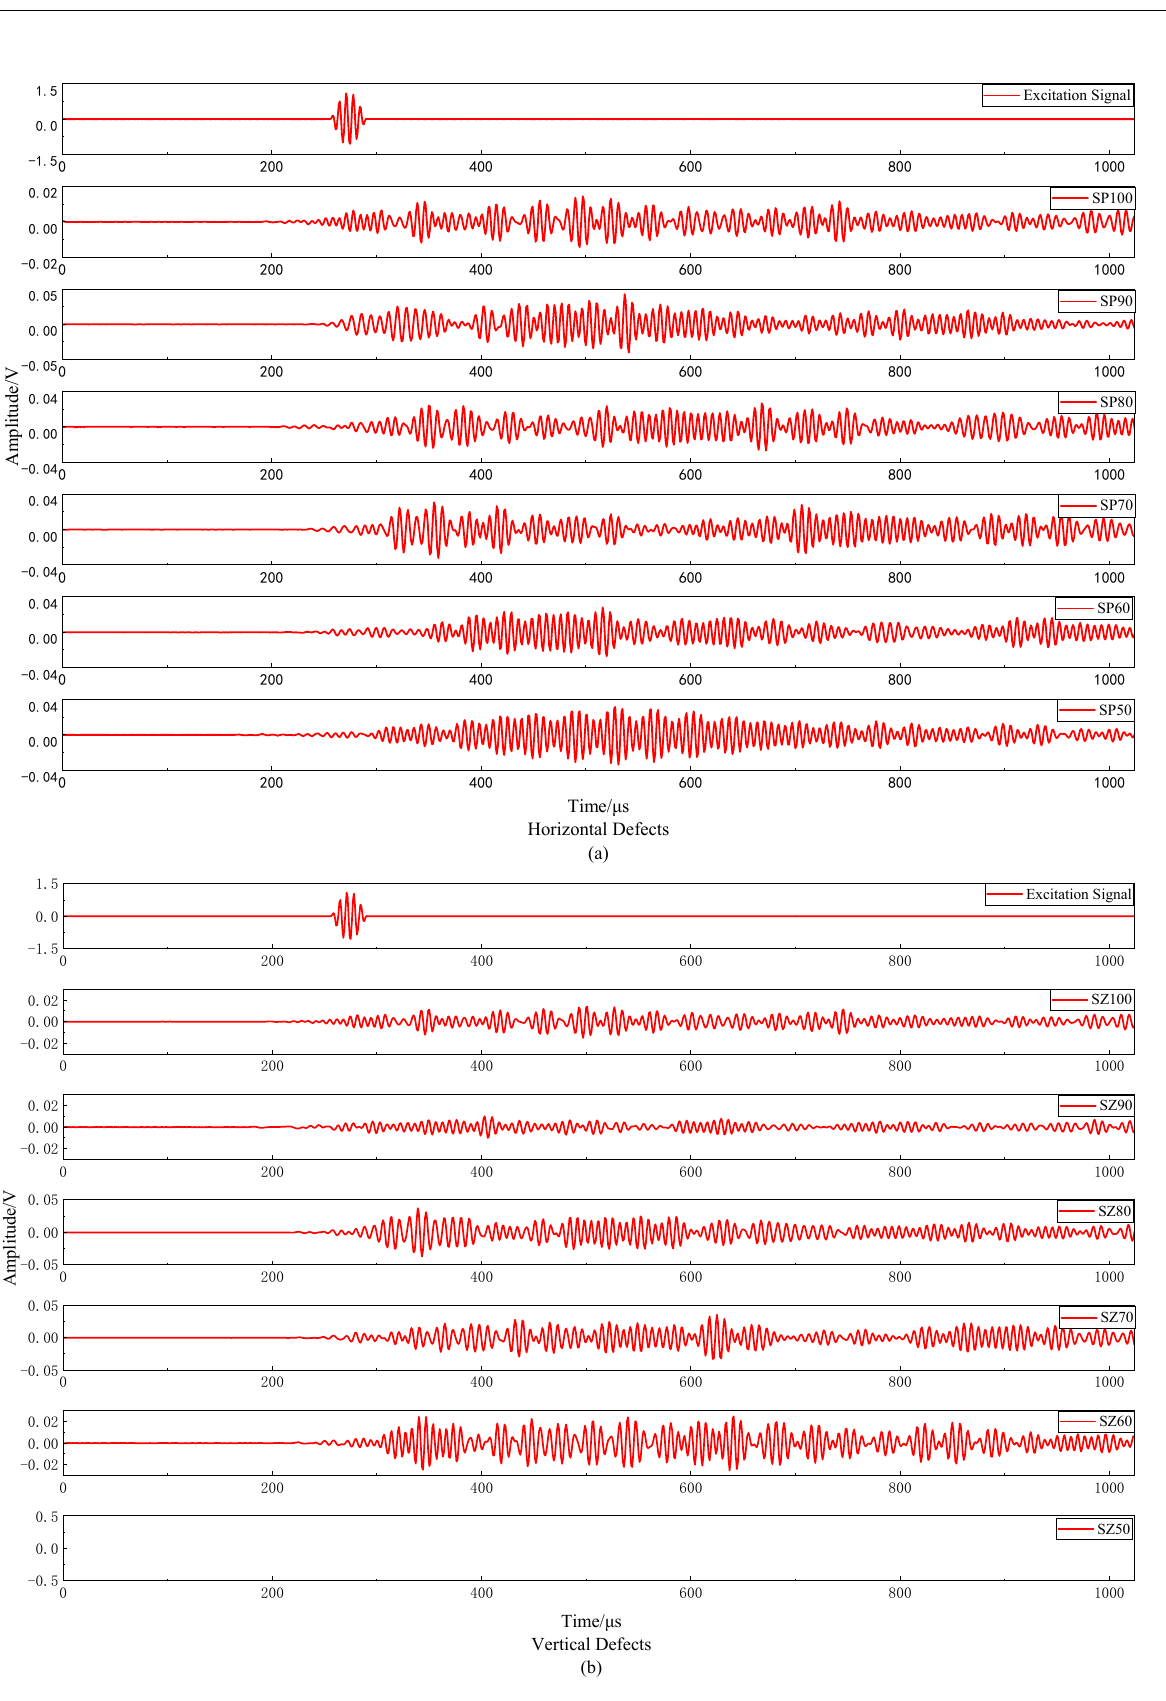
Figure 5. Receiving waveform of each group of specimens.